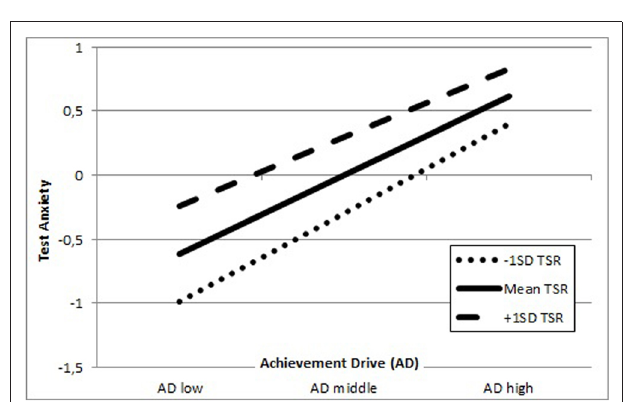
FIGURE 2 | Representation of student–student relationships (SSR) as moderator in the association of achievement drive (AD) and test anxiety (TX) for Canadian secondary school students; the Y-axis measures test anxiety and the X-axis indicates achievement drive.